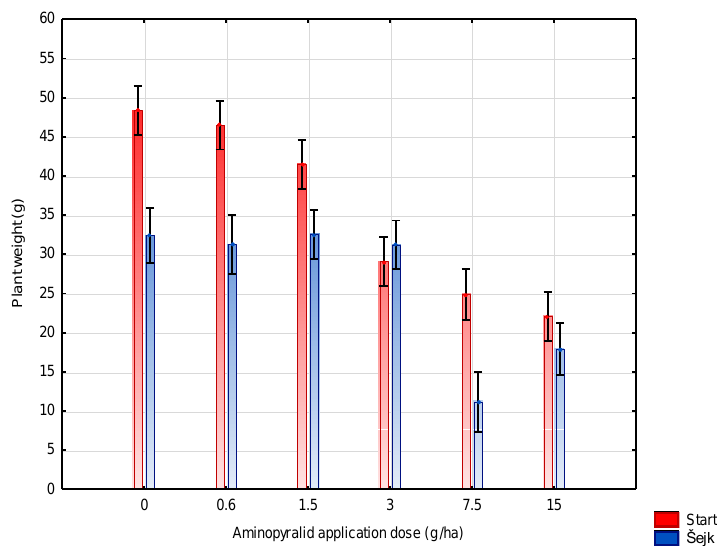
Figure 5. Effect of gradual aminopyralid treatment on the weight of aboveground phytomass in grams; ANOVA with Fisher ´ s LSD post hoc test ( α = 0,05; n = 10), bar is a standard deviation, significantly different classes of values were added in separate Table S2 in Supplementary Materials.